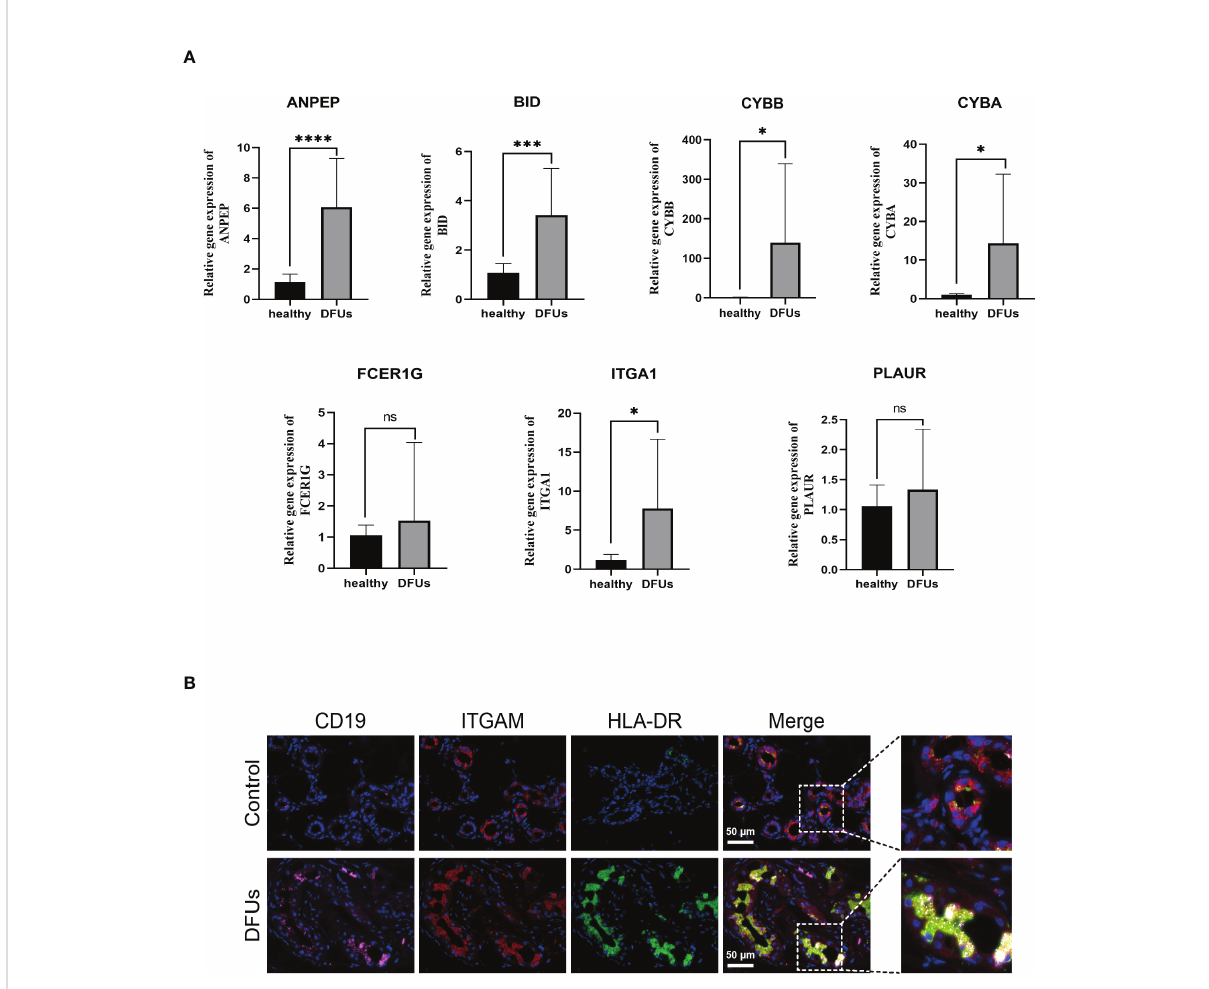
FIGURE 8 he relationship between drug target gene and DFU immune microenvironment was detected. (A) the expression levels of ANEP, BID, CYBA, CYBB, FCER1G, ITGA1 and PLAURmRNA in blood were detected for the fi rst time by qRT-PCR. (B) the coexistence of CD19, ITGAM and human leukocyte antigen DR in DFU skin tissue and mononuclear macrophages was analyzed by laser confocal microscope and immuno fl uorescence triple labeling technique. ns, no signi fi